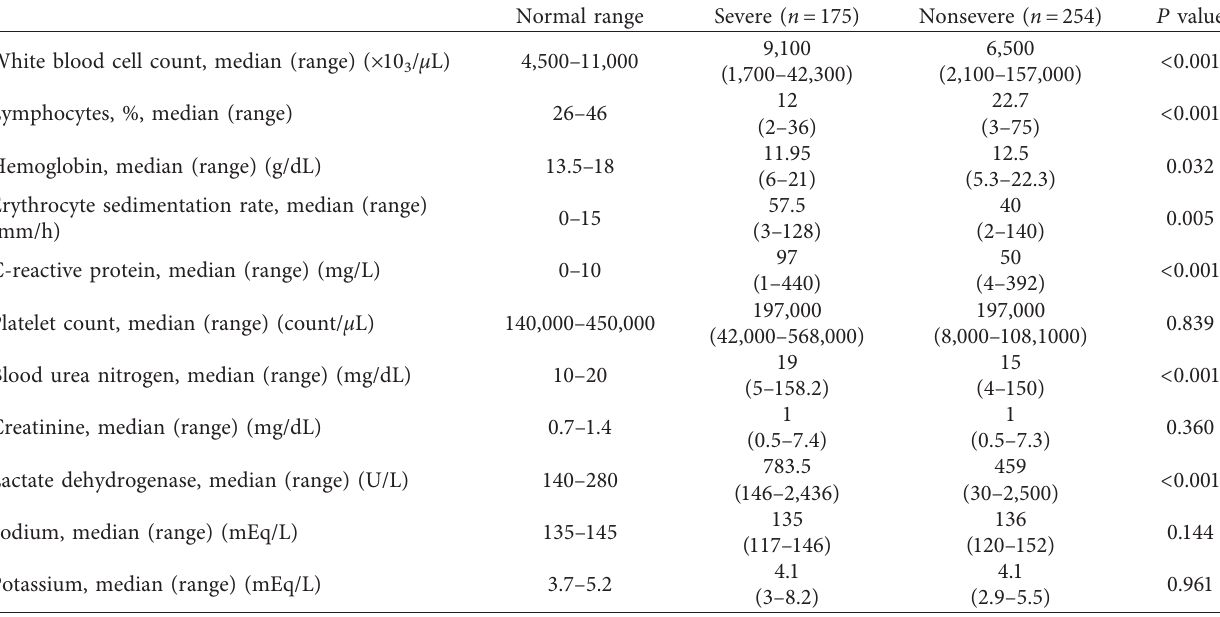
Table 2: Laboratory findings of severe and nonsevere COVID-19 patients.